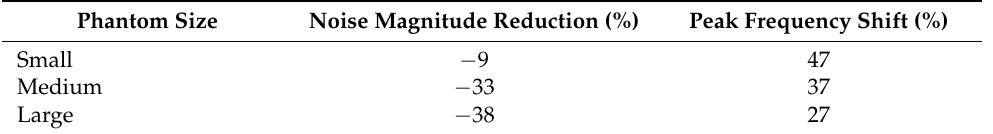
Figure 3. NPS curves obtained on a clinical EID ‐ CT (solid lines) and a prototype PCD ‐ CT (dashed lines) system at various phantom sizes. The area under the curve is representative of the noise magnitude, whereas the NPS center frequency indicates differences in noise texture. NPS—noise power spectrum; PCD ‐ CT—photon ‐ counting detector computed tomography; EID ‐ CT—energy ‐ integrating detector computed tomography. Table 2. Noise magnitude reduction and NPS peak frequency shift in percentage differences for PCD ‐ CT in comparison with EID ‐ CT at the three investigated patient sizes.